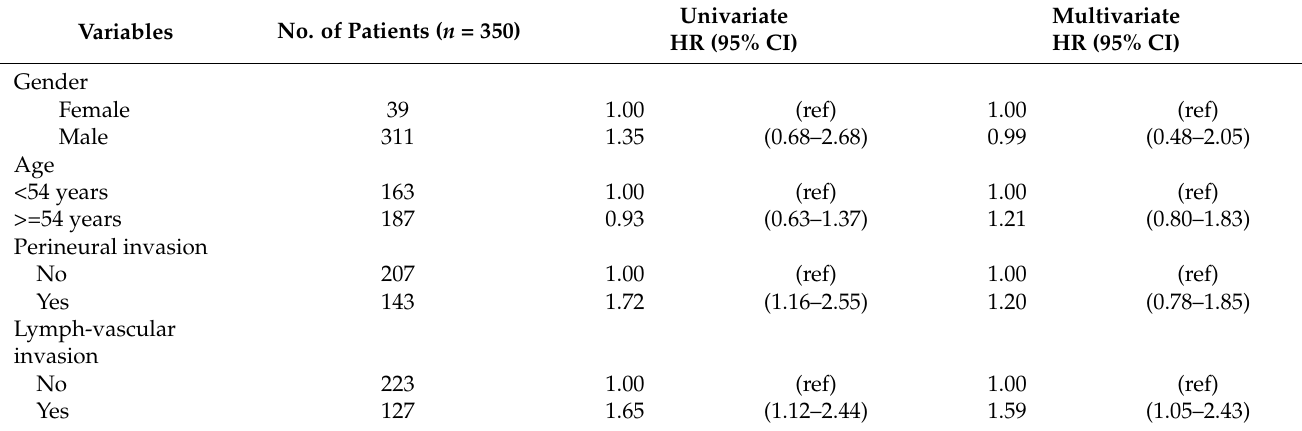
Table 5. Factors associated with disease-specific survival in late-stage oral cavity cancer